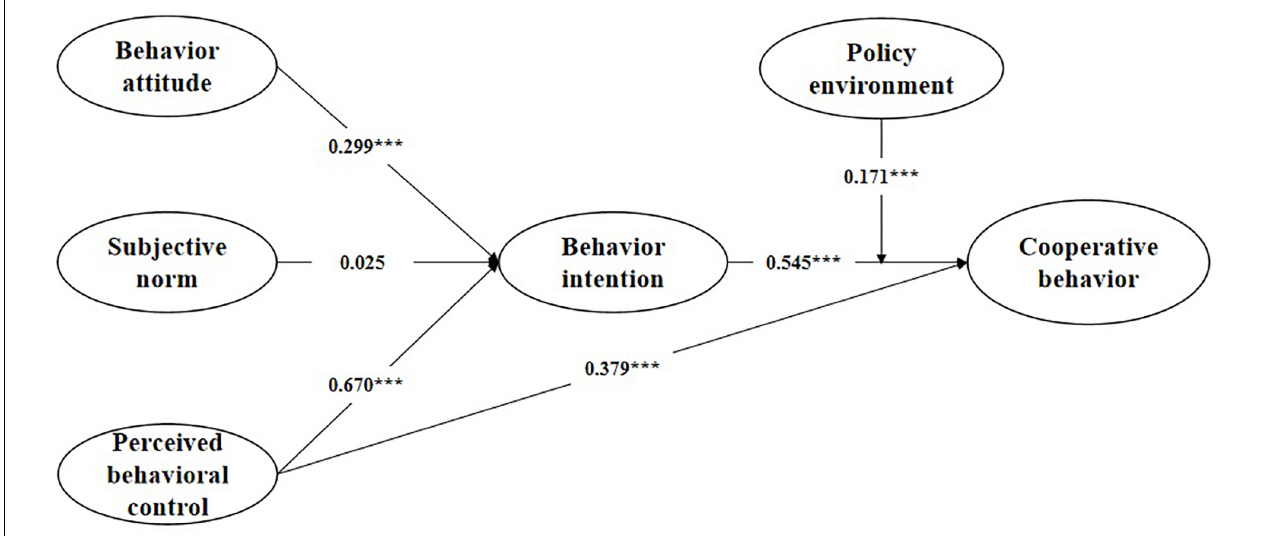
FIGURE 2 | The results of the research model. * p < 0.05, ** p < 0.01, *** p < 0.001.